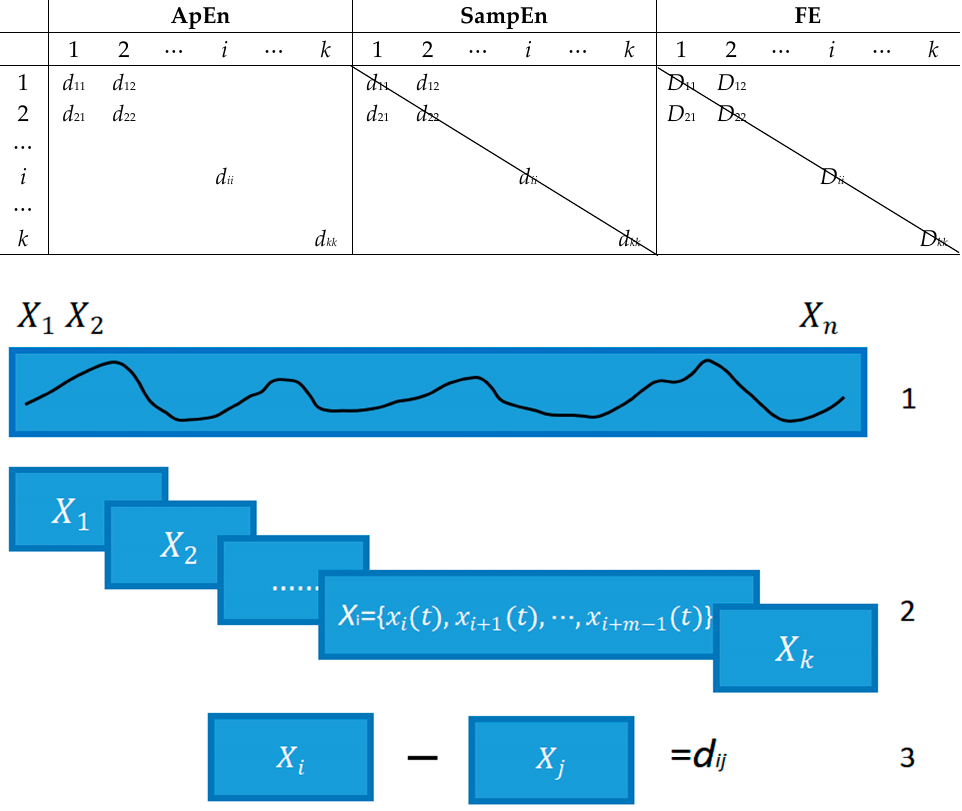
Figure 3. Calculation process of entropy value. Table 1. Statistical table of ApEn, SampEn, FE. Table 1. Statistical table of ApEn, SampEn, FE. ApEn SampEn FE